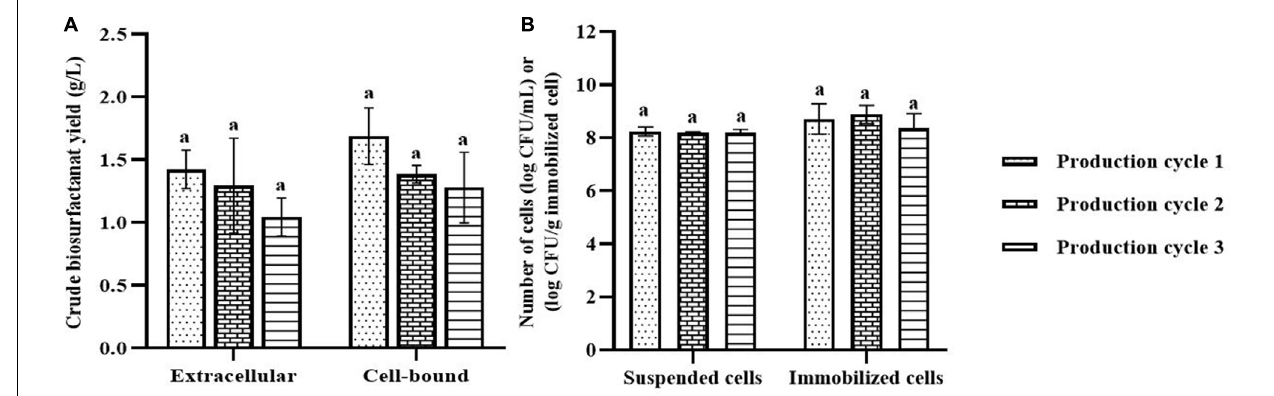
Lowest surface yield (g/L)* tension